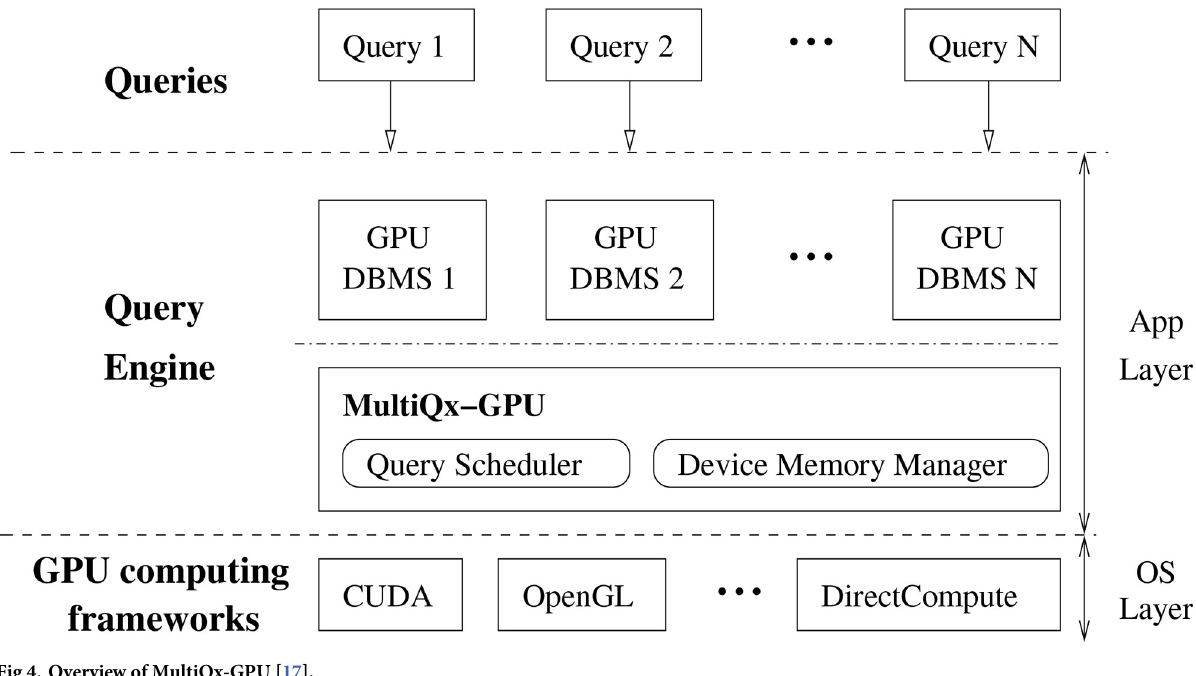
Fig 4. Overview of MultiQx-GPU